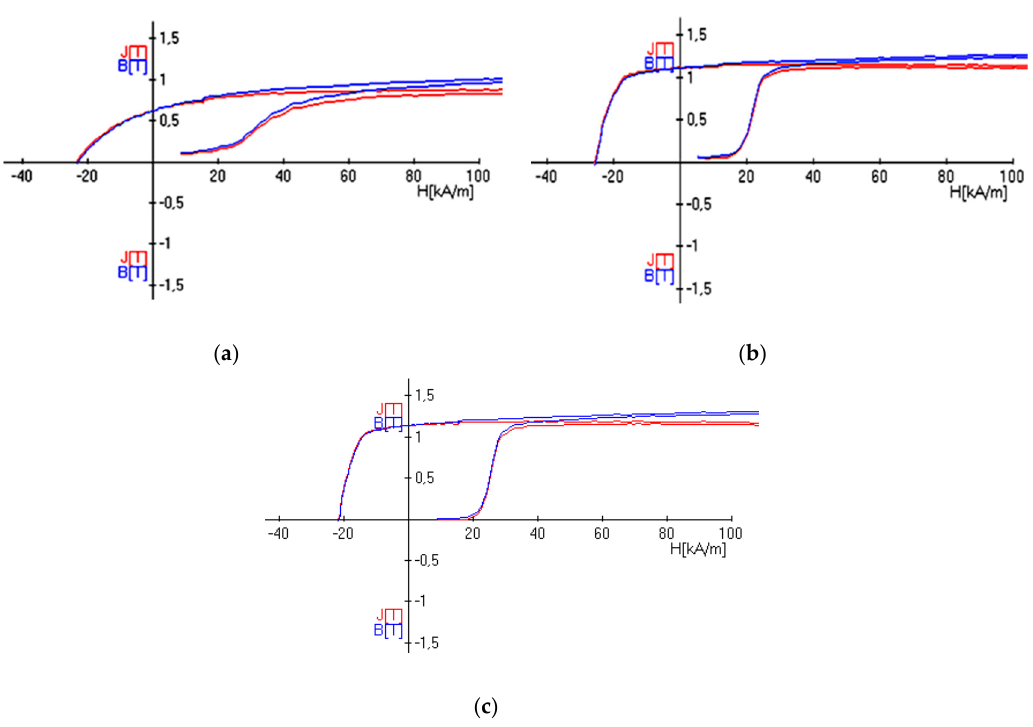
Figure 5. Magnetization curves of the samples after deformation by tension and torsion at 750 °C ( a ), 800 °C ( b ), and 850 °C ( c ) and magnetic treatment.